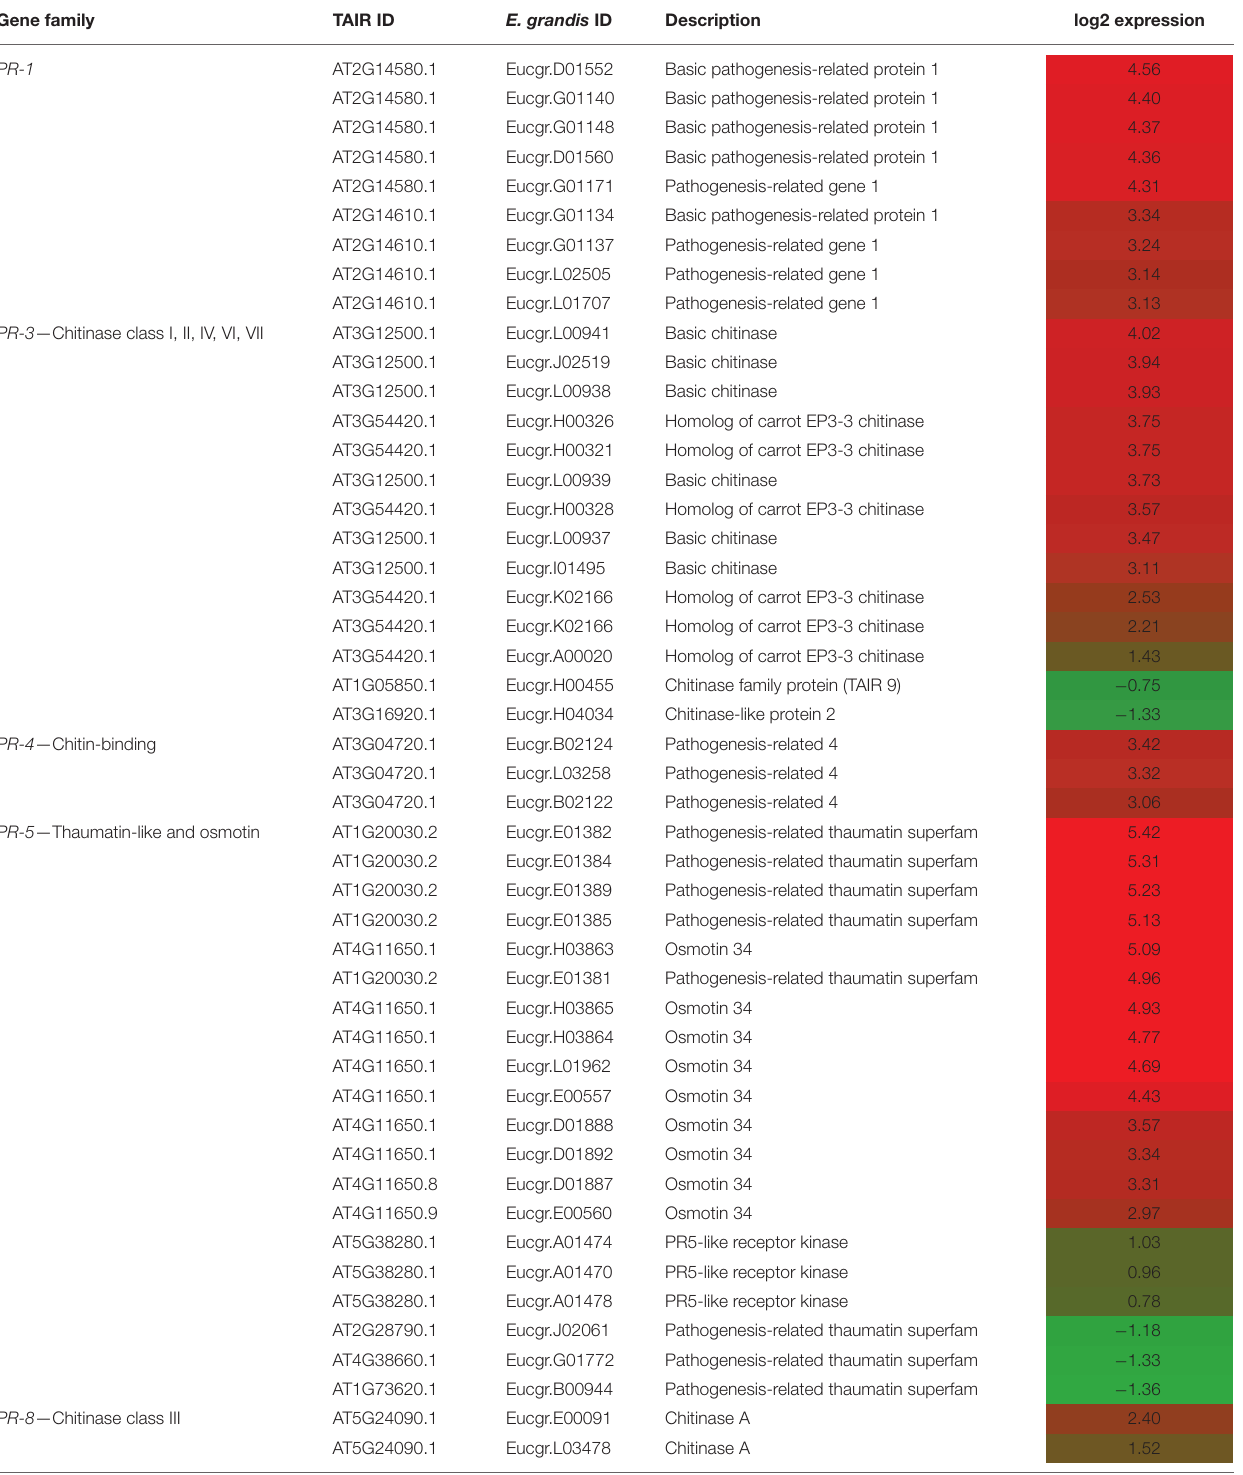
TABLE 4 | Expression of pathogenesis related genes in response to Phytophthora cinnamomi inoculation in Eucalyptus nitens